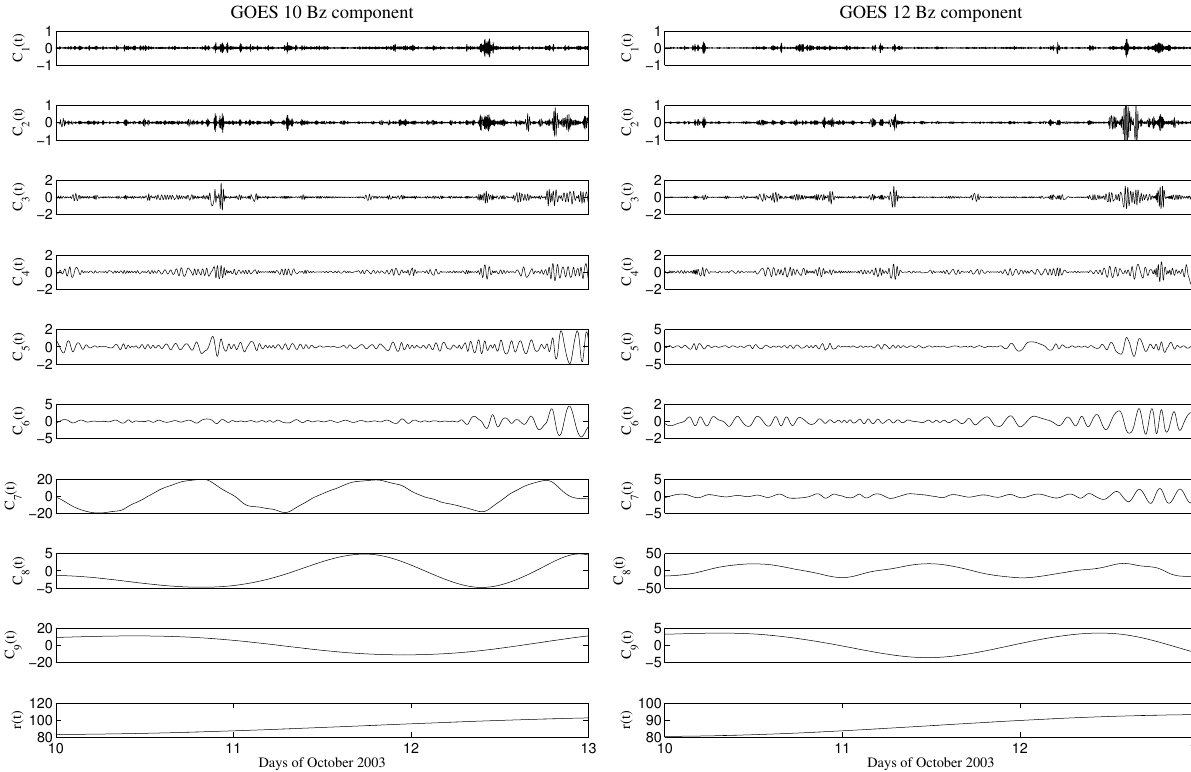
Figure 6. SSQ, 10–12 October 2003: empirical modes extracted via EMD from GOES10 (left panels) and GOES12 (right panels) B z components. The modes and the residues are expressed in nanotesla, with a time resolution of